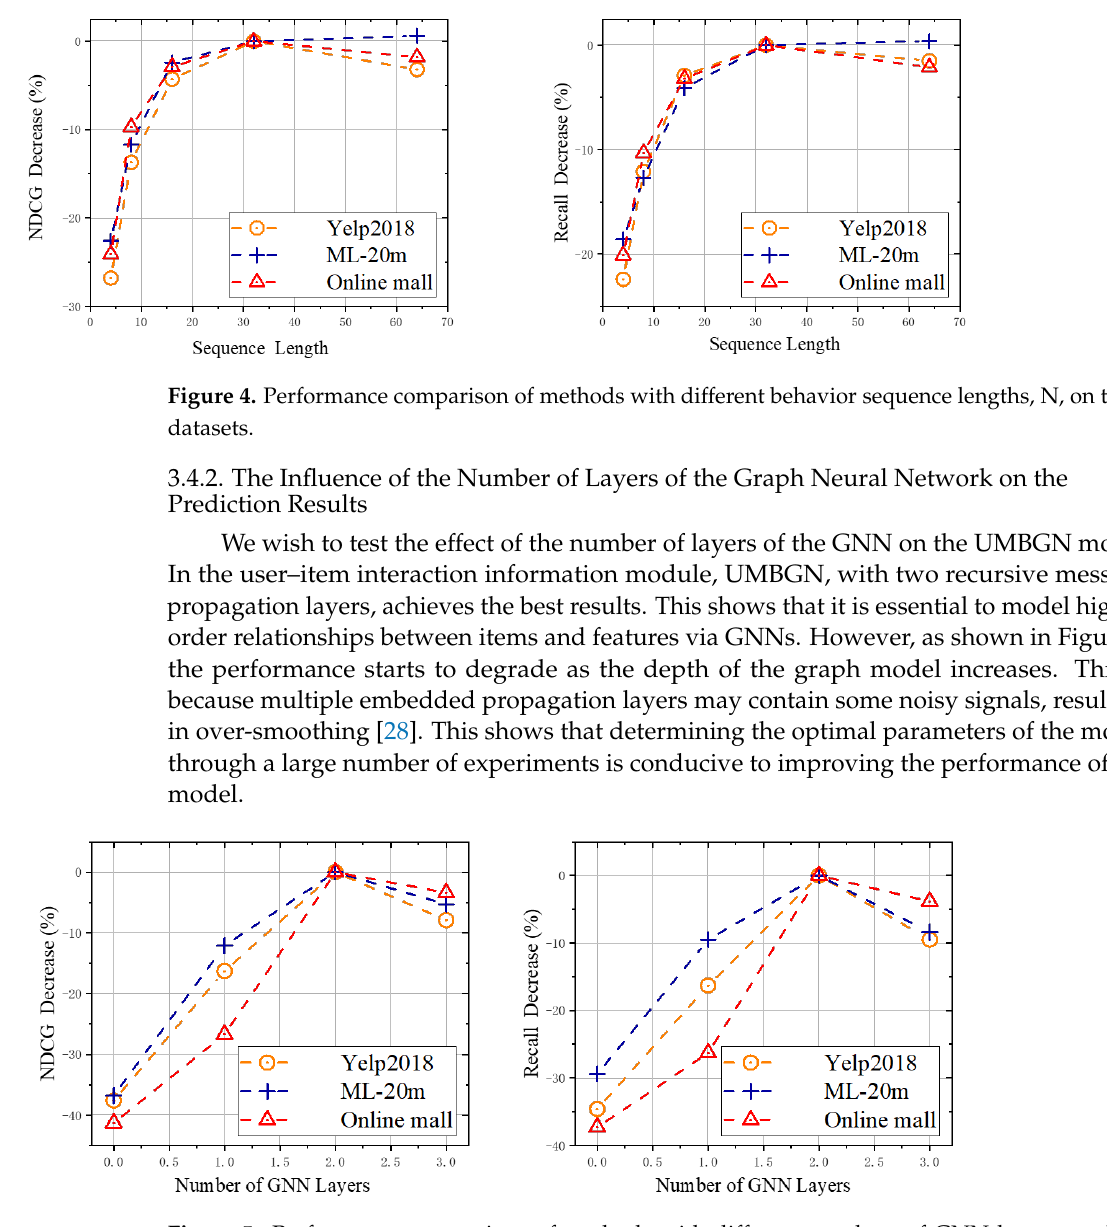
Figure 5. Performance comparison of methods with different numbers of GNN layers on three datasets.